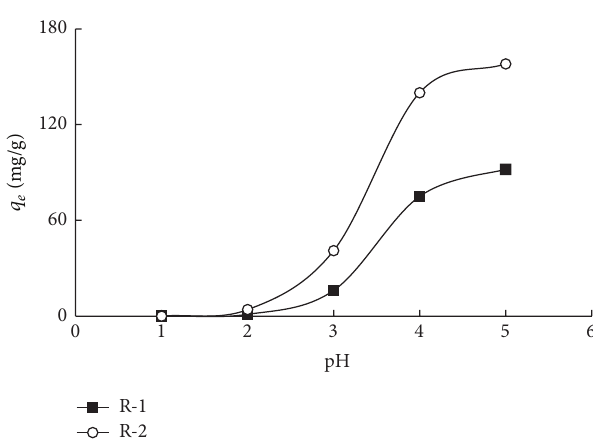
Figure 1: Effect of pH on adsorption